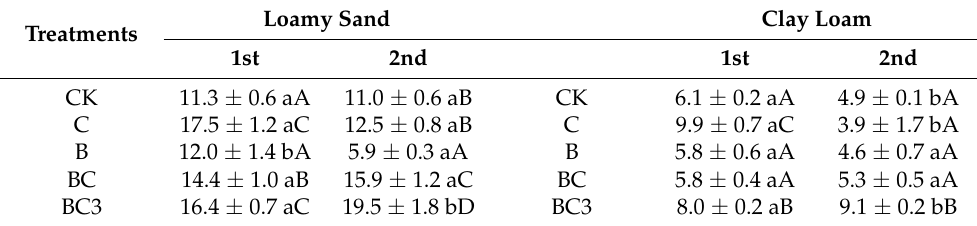
Table 5. NUE of the crops